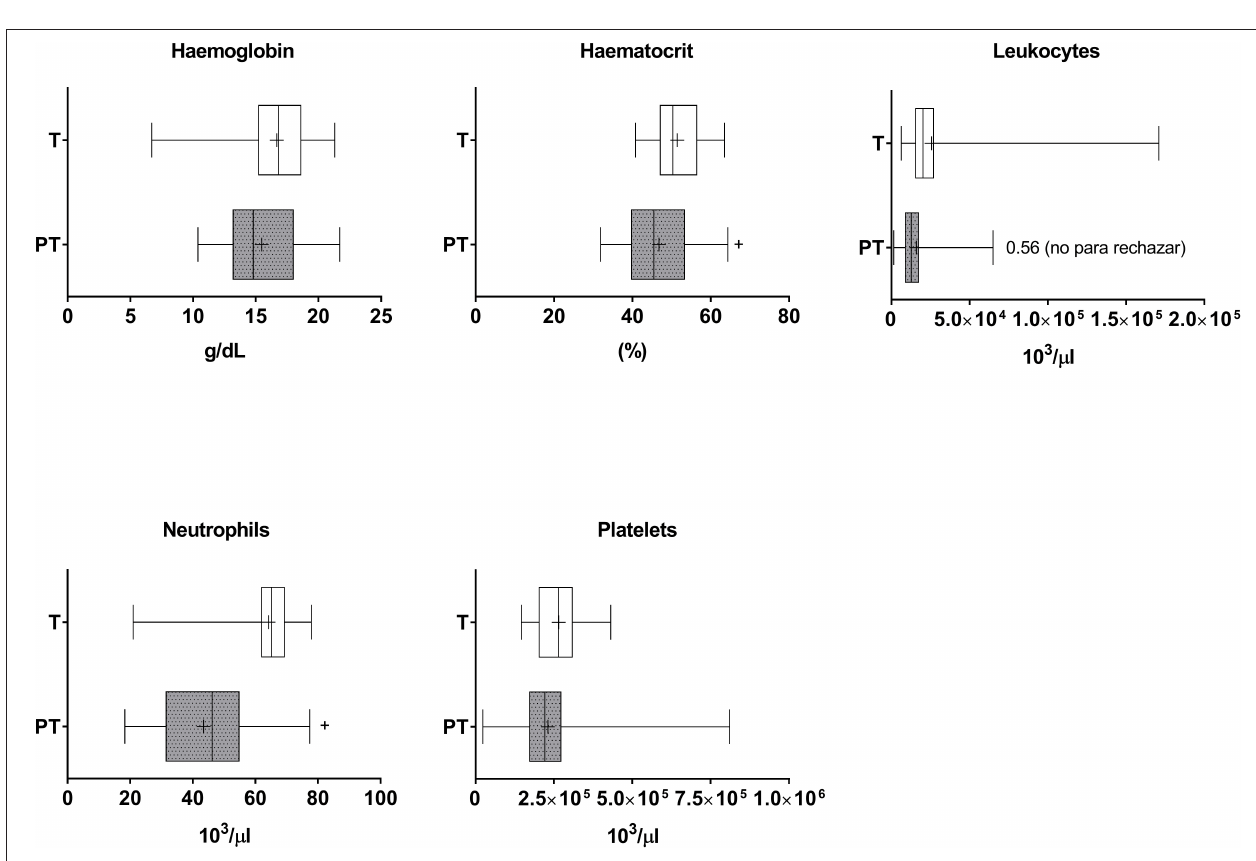
FIGURE 4 | Haematological markers in the plasma of T and PT newborns. Haemoglobin, haematocrit, total leukocytes, neutrophils and platelets are shown. + p < 0.05 vs. T.